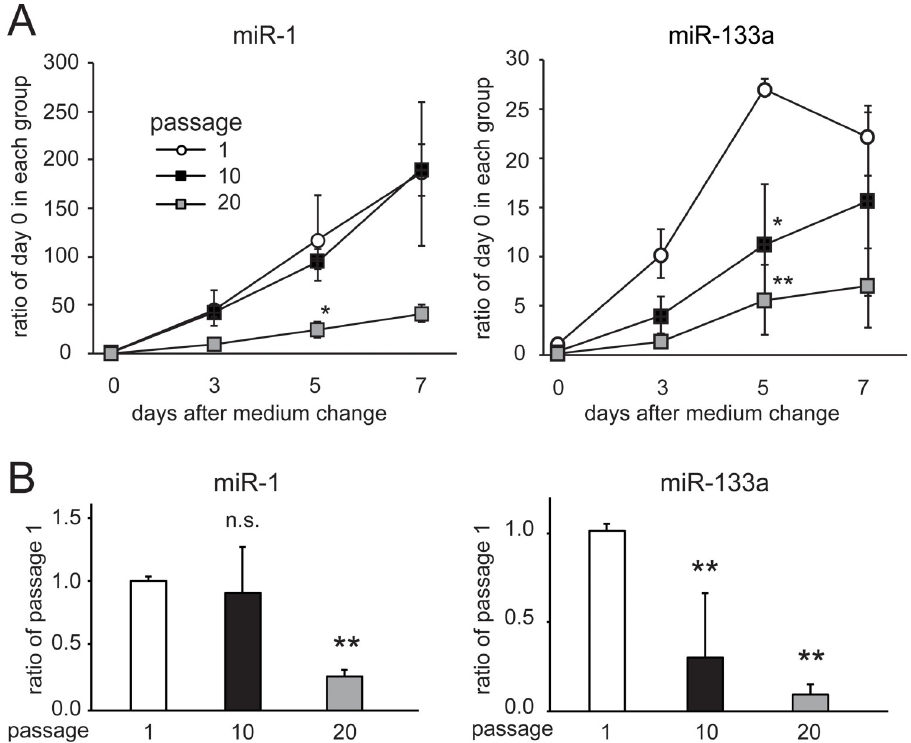
Fig 4. Effect of replicative senescence on miR-1 and miR-133a expression. Panel A shows the time course of miR-1 and miR-133a levels after changing the medium for myogenic differentiation. Myogenic differentiation was induced in cells subjected to passage once (passage 1), 10 times (passage 10), or 20 times (passage 20). Data are presented as means ± SE (n = 6 dishes). � P < 0.05, �� P < 0.01 vs. passage 1 at each time point (Tukey–Kramer test). Panel B shows the relative levels of miR-1 and miR-133a in cells just before changing the medium for myogenic differentiation (day 0 in Fig 4A). Data are presented as means ± SE (n = 6 dishes). �� P < 0.01 vs. passage 1 (Dunnett’s test).